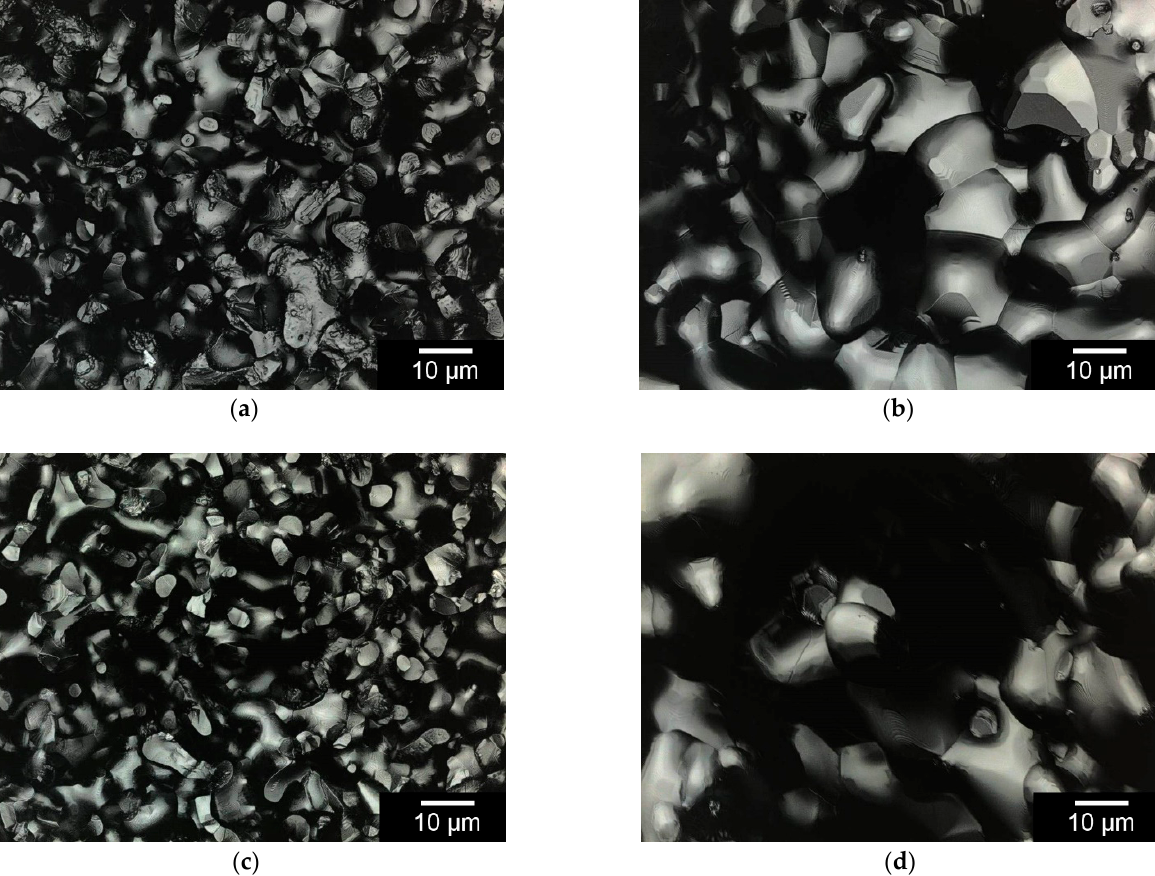
Figure 4. 3D laser scanning microscopy images of the surface of ( a ): RMS and ( b ): Curasan Ceramics, Inner surface after incubation in TRIS buffer pH 7.4 for 60d ( c ): RMS and ( d ): Curasan ceramics; white bar represents 10 µm, Images taken with KEYENCE VK-X210 .